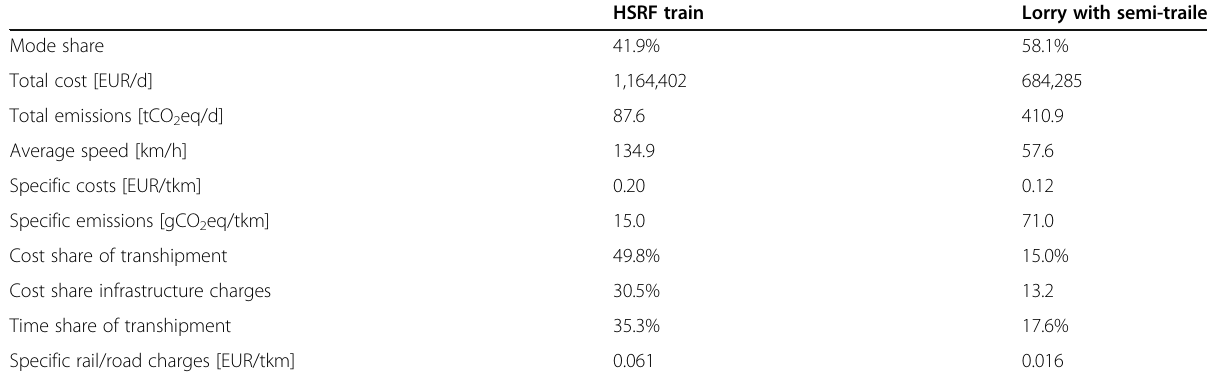
Table 3 Simulation results for European scenario 2030 with baseline parameter setting